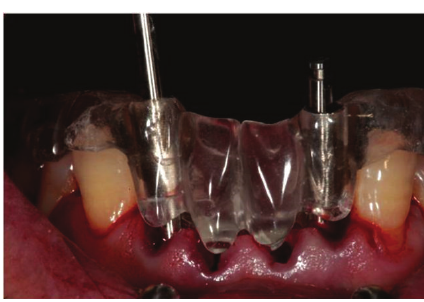
Figure 4: Surgical guide.